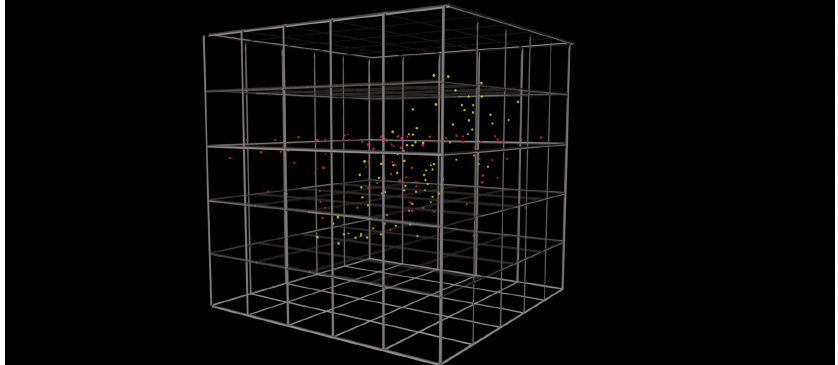
Figure 11. Visualization of two detected clusters (red and yellow) with the predefined subspace clustering grid. Clusters are even detected in overlapping point